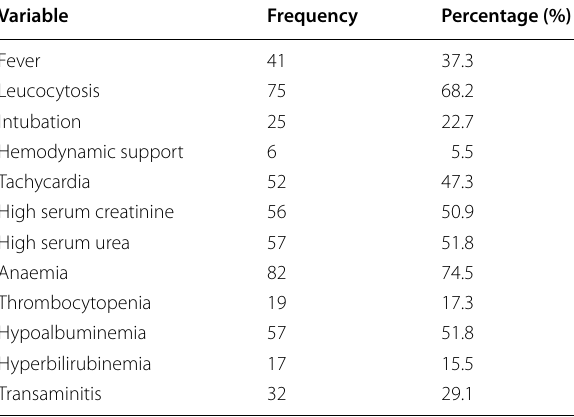
Table 2 Patients’ laboratory data on the first day of